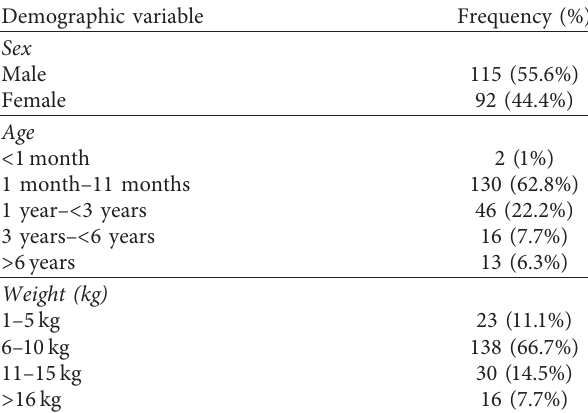
Table 1: Demographic characteristics of the children admitted with pneumonia at pediatric ward of Tikur Anbessa Specialized Hospital from February 2017 to February 2018, Addis Ababa, Ethiopia ( N �